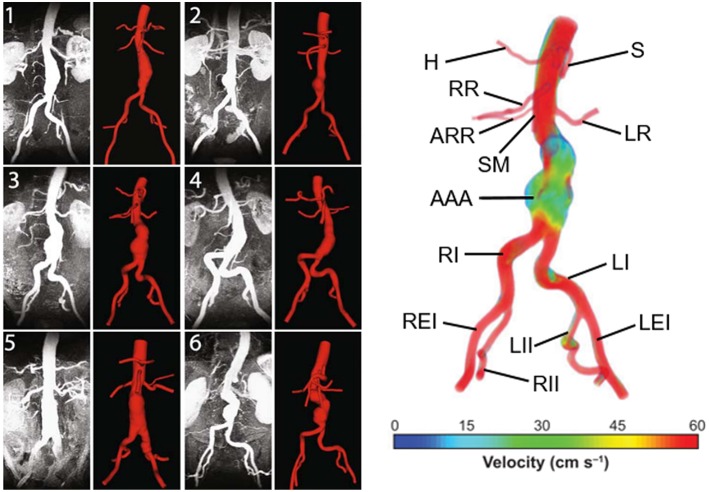
Six different patient-specific medical images and corresponding reconstructed AAA geometries. The branching arteries and disturbed AAA flow in the 3rd patient-specific medical image are described at the right side. Compared to undilated vessel, the flow hemodynamics in the AAA sac changed significantly. The artery labels are as follows: H, Hepatic artery; S, Splenic artery; RR, Right renal artery; ARR, Accessory right renal artery; SM, Superior mesenteric artery; LR, Left renal artery; AAA, Abdominal aortic aneurysm; RI, Right iliac artery; LI, Left iliac artery; REI, Right external iliac artery; RII, Right internal iliac artery; LII, Left internal iliac artery; LEI, Left external iliac artery [The figure is adapted from Les et al. (2010) and used with permission].